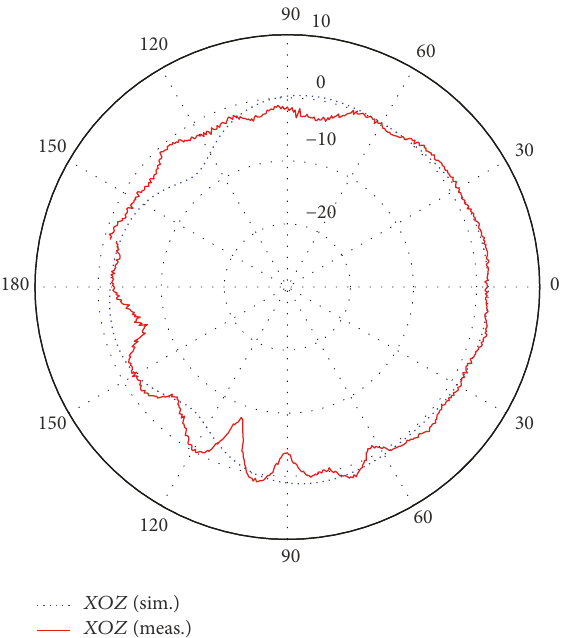
Figure 18: Radiation pattern of the antenna in XOZ plane at 5.85 GHz.